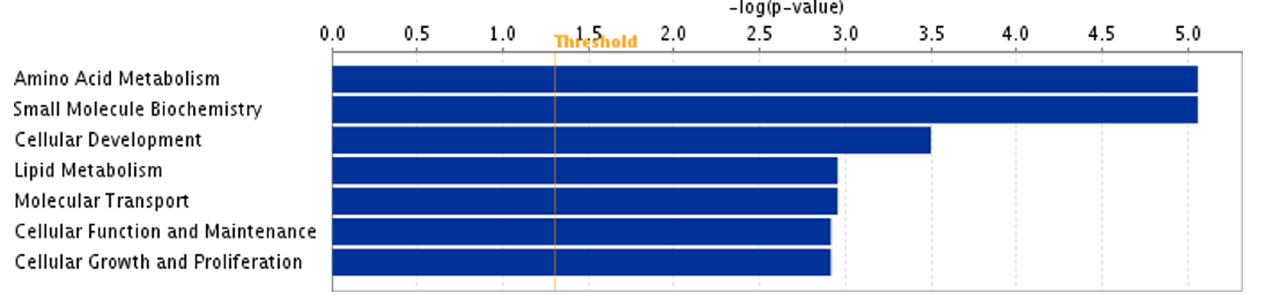
Figure 3. Functional grouping of DEGs in liver with high and low androstenone using Ingenuity Pathways Analysis software. The most significant functional groups ( p , 0.05) are presented graphically. The bars represent the p -value on a logarithmic scale for each functional group.